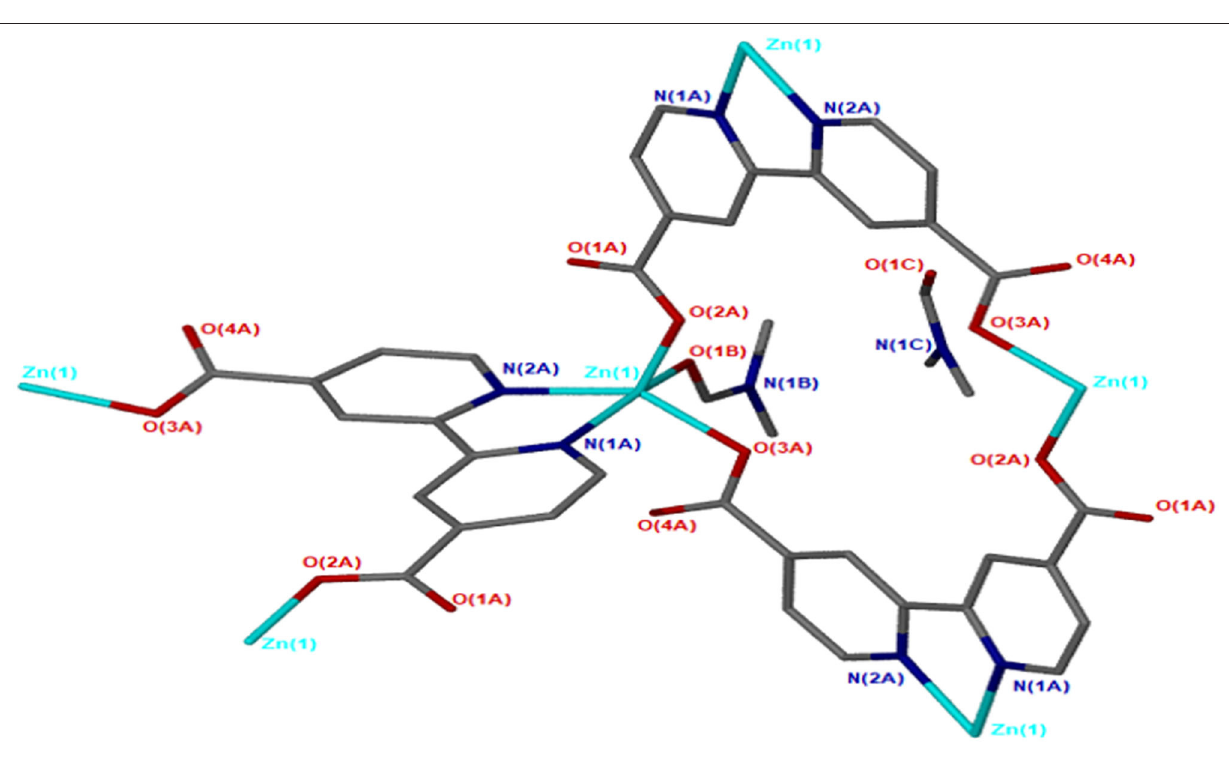
The observed rectangular channels which are occupied by both coordinated and uncoordinated DMF molecules (10.342 × 9.036 Å) run along b -axis. PLATON (Spek, 2009) estimates that the